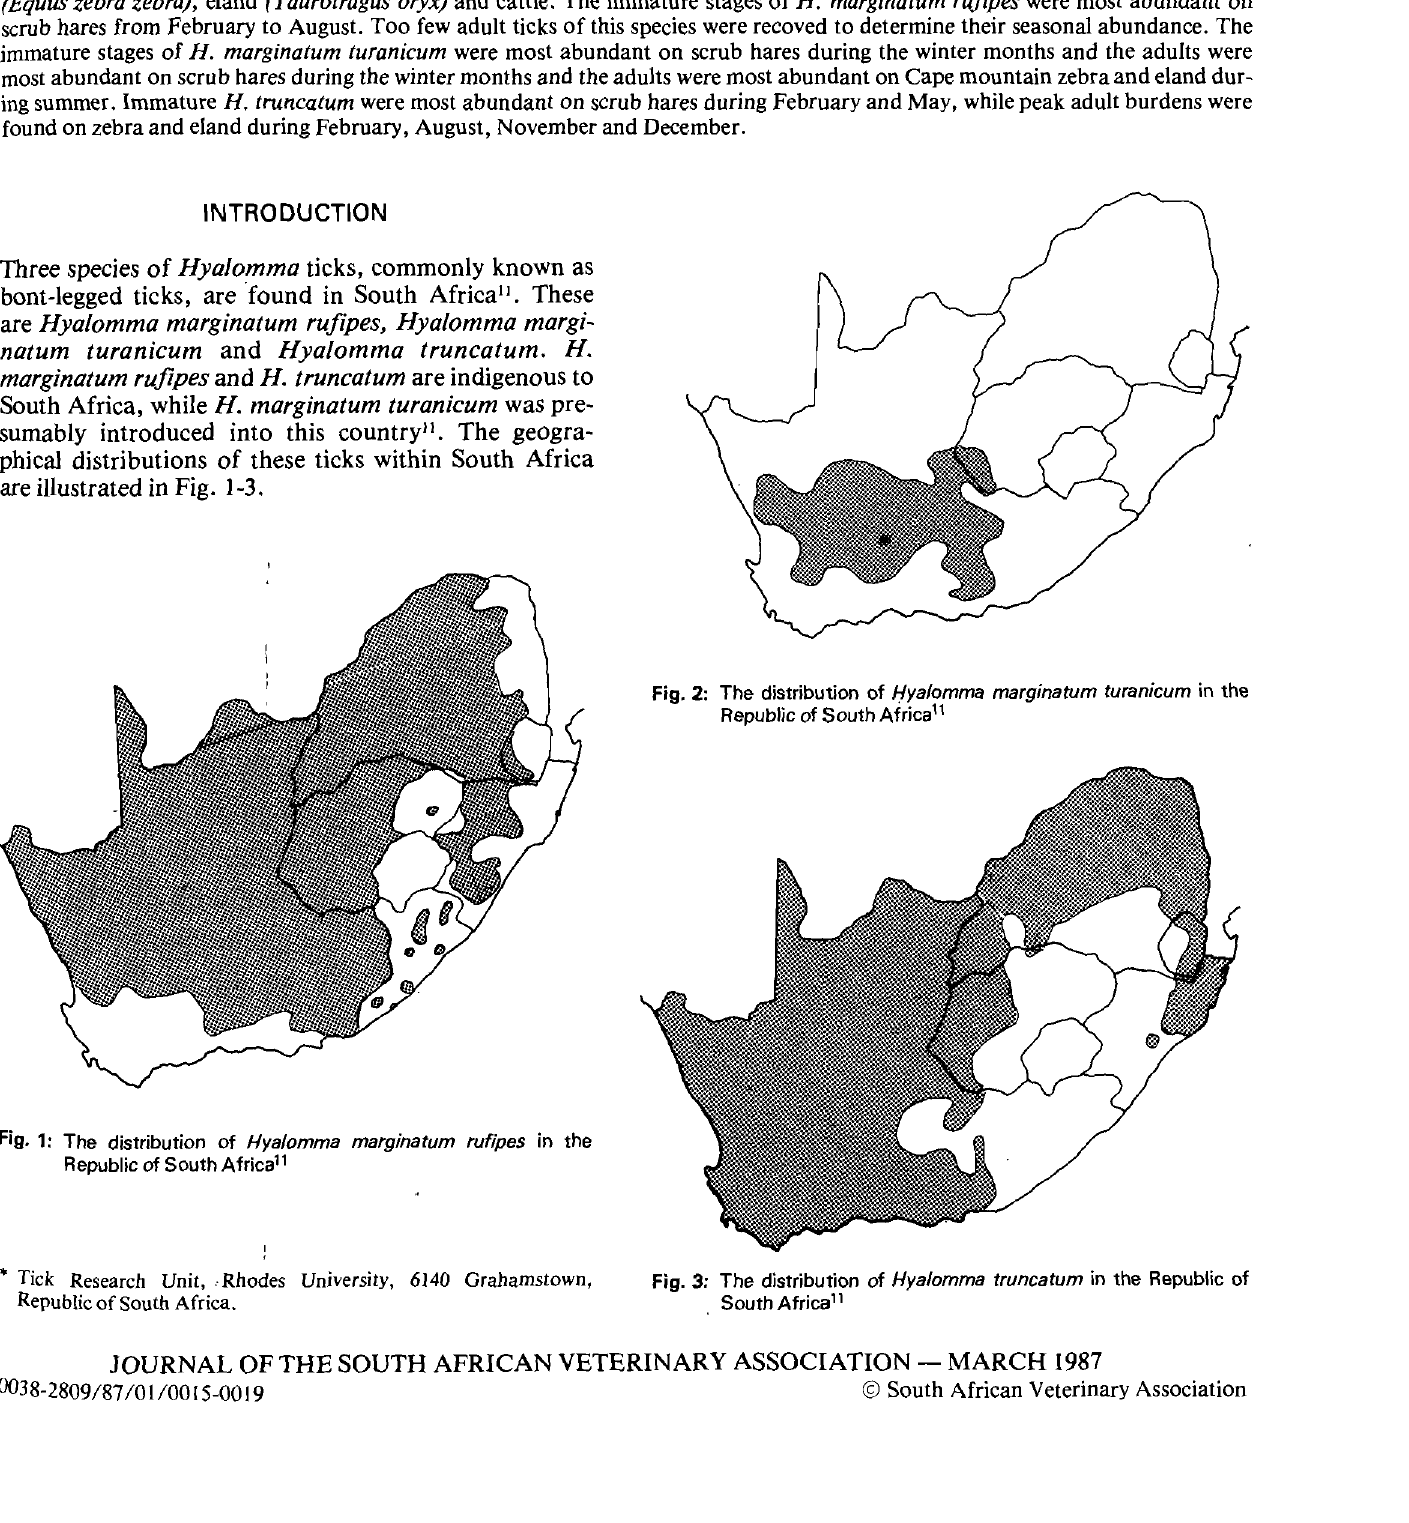
Fig. 1: The distribution of Hyalomma marginatum rufipes in the Republic of South Africa 11